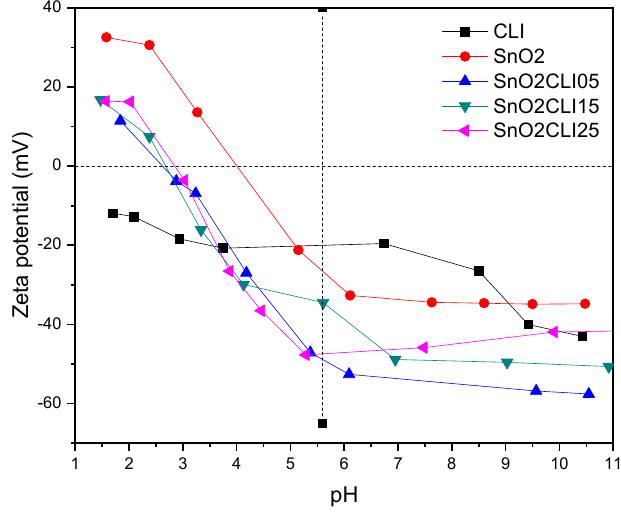
Figure 8. Surface charges of CLI, SnO 2 , and SnO 2 -containing clinoptilolite samples.